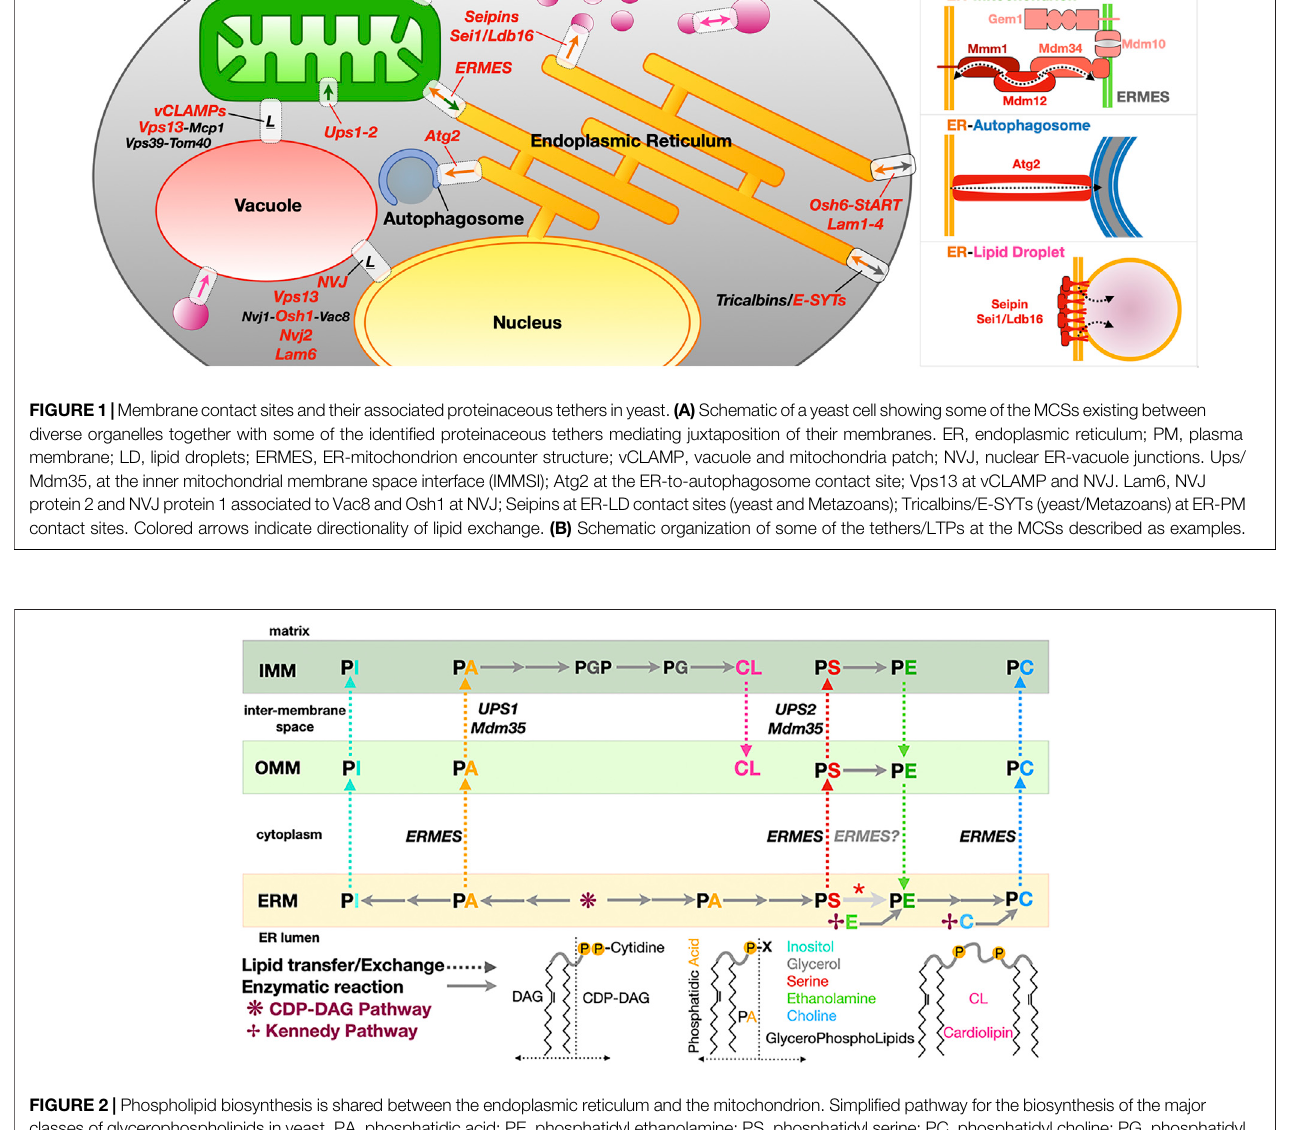
Frontiers in Cell and Developmental Biology |